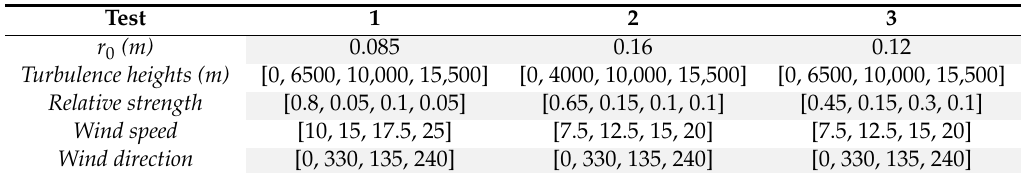
Table 1. Properties of the parameters for the turbulence in the three multilayer